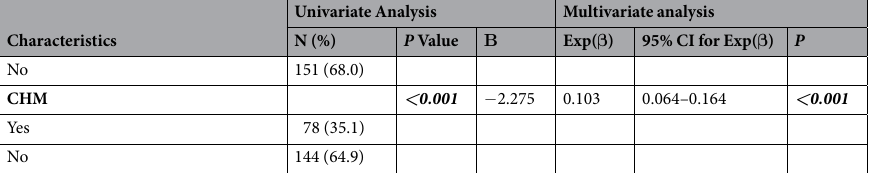
Table 1. Univariate and multivariate analyses of variables affecting the survival of 222 patients with mCRC. CHM , Chinese herbal medicine; CEA , carcinoembryonic antigen; CA-199 , carbohydrate antigen 199; CA-242 ,